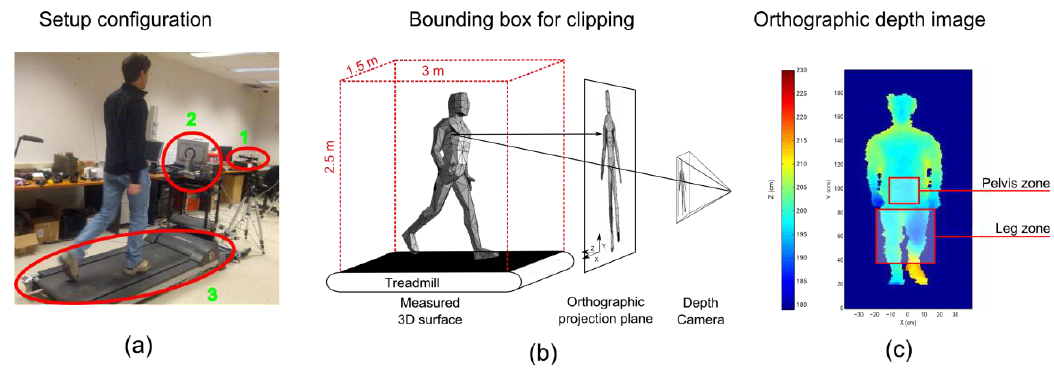
Figure 1. ( a ) Representation of the experimental set-up featuring the depth camera (1), the recording computer (2) and the treadmill (3); ( b ) representation of the orthographic projection operation and the bounding box in red, chosen to isolate the points belonging to the subject; ( c ) the orthographic depth image showing the parts of the body defining the limits of the regions of interest used for the registration operation and asymmetry indices’